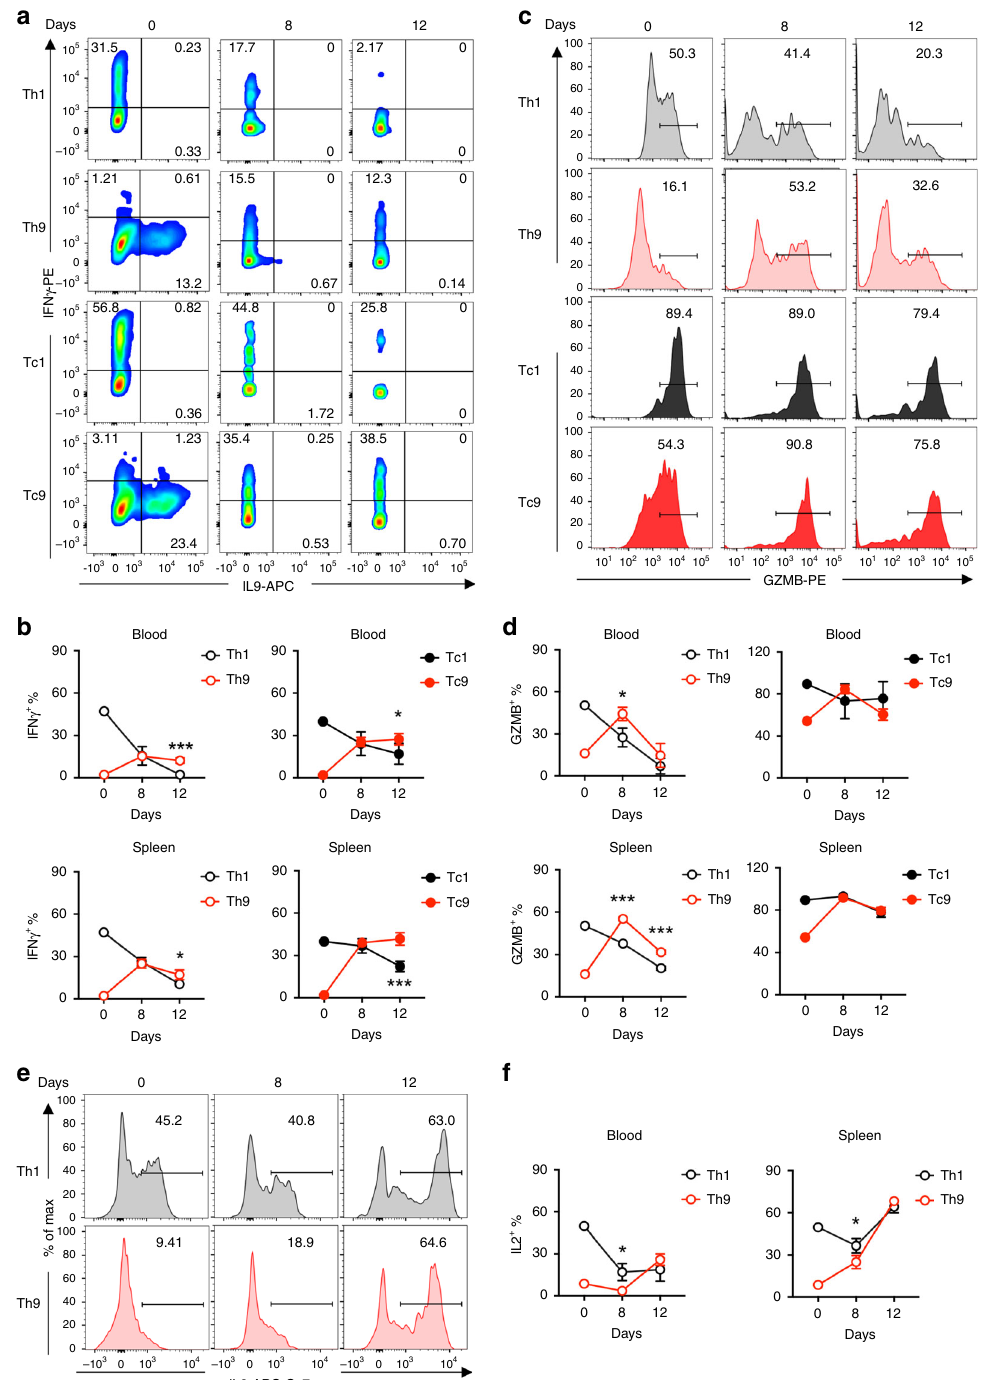
Fig. 5 T9 CAR-T cells acquire effector function in vivo after transfer. a Representative fl ow plots showing the percentages of IFN- γ -expressing and IL9- expressing CD4 + (Th1 or Th9) and CD8 + (Tc1 or Tc9) CAR-T cells from spleen of treated mice at day 8 after transfer. b Summarized data ( n = 5 mice) showing the frequency of IFN- γ -expressing CD4 + (Th1 or Th9; left panels) and CD8 + (Tc1 or Tc9; right panels) CAR-T cells in peripheral blood (upper panels) or spleen (lower panels) of treated mice at days 8 and 12 after transfer. c Representative fl ow plots showing the percentage of GrzB-expressing CD4 + (Th1 or Th9) and CD8 + (Tc1 or Tc9) CAR-T cells from spleen of treated mice at days 8 and 12 after transfer. d Summarized data ( n = 5 mice) showing the frequency of GrzB-expressing CD4 + (Th1 or Th9; left panels) and CD8 + (Tc1 or Tc9; right panels) CAR-T cells in peripheral blood (upper panels) or spleen (lower panels) of treated mice at days 8 and 12 after transfer. e Representative fl ow plots showing the percentage of IL2-expressing CD4 + CAR-T cells from spleen of treated mice at days 8 and 12 after transfer. f Summarized data ( n = 5 mice) showing the frequency of IL2-expressing CD4 + CAR-T cells in peripheral blood and spleen of treated mice at days 8 and 12 after transfer. Data are presented as mean ± SD. * P < 0.05 and *** P < 0.001, two-sided Student ’ s t -test. Source data are provided as a Source Data fi